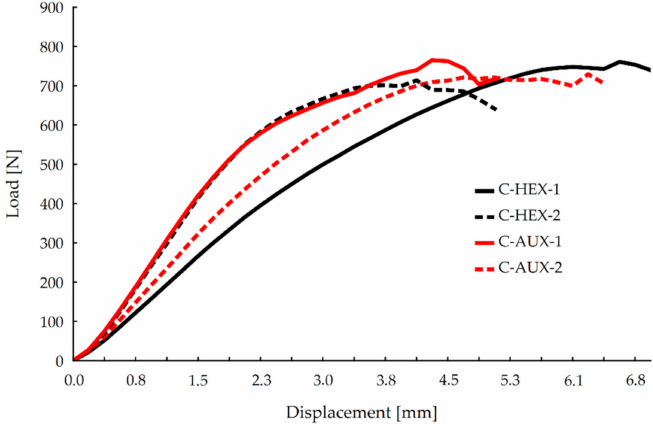
Figure 5. Sti ff ness of joints in the compression